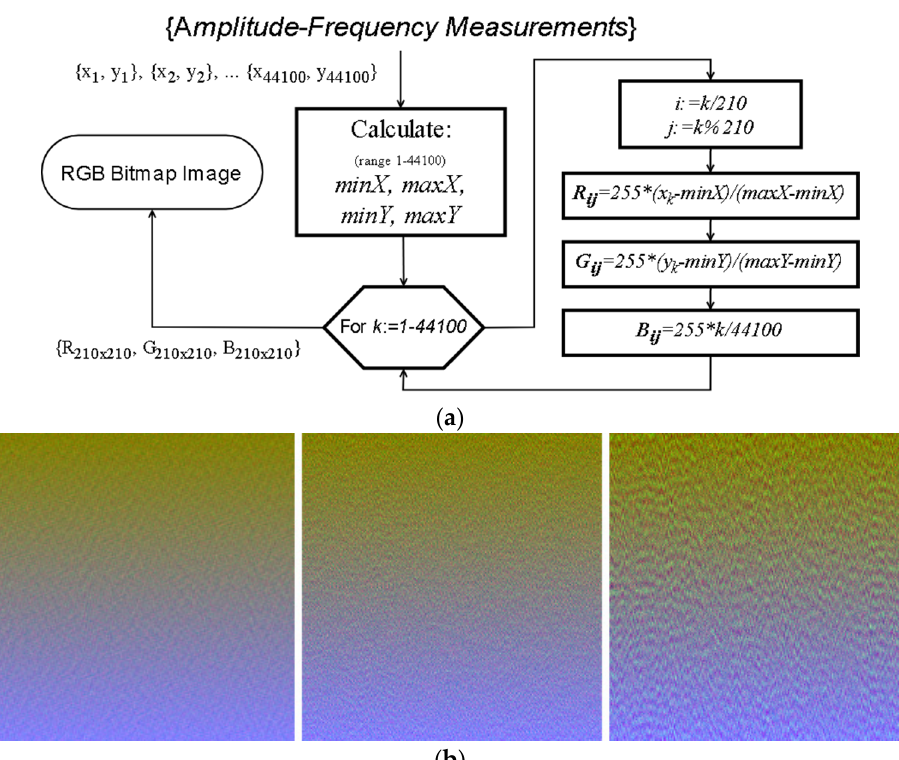
Figure 6. ( a ) Detailed diagram of the algorithm for converting measurements to RGB images. ( b ) An example of processing acoustic signals: on the left, from a defect-free pipeline; in the center, from a pipeline with a defect of the “crack” type; on the right, from a pipeline with a defect of the “hole” type.